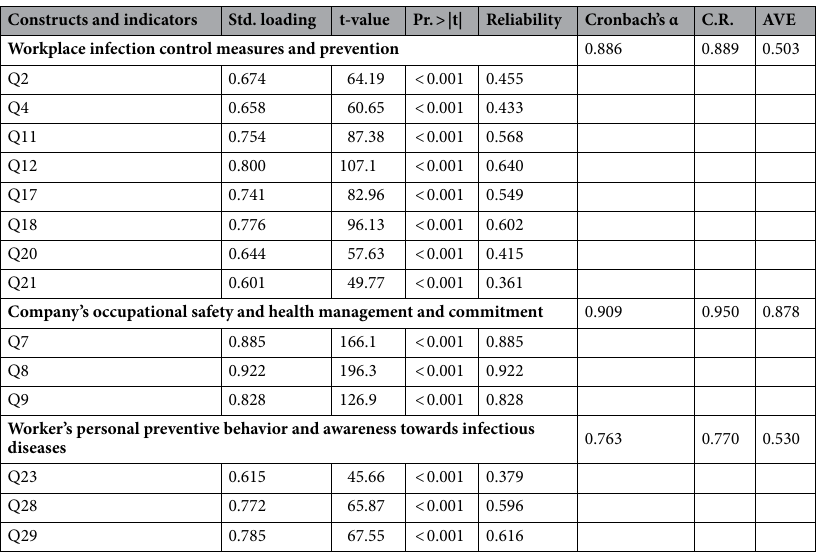
Table 4. Construct reliability test results. std standard, AVE average variance extracted, C.R. composite